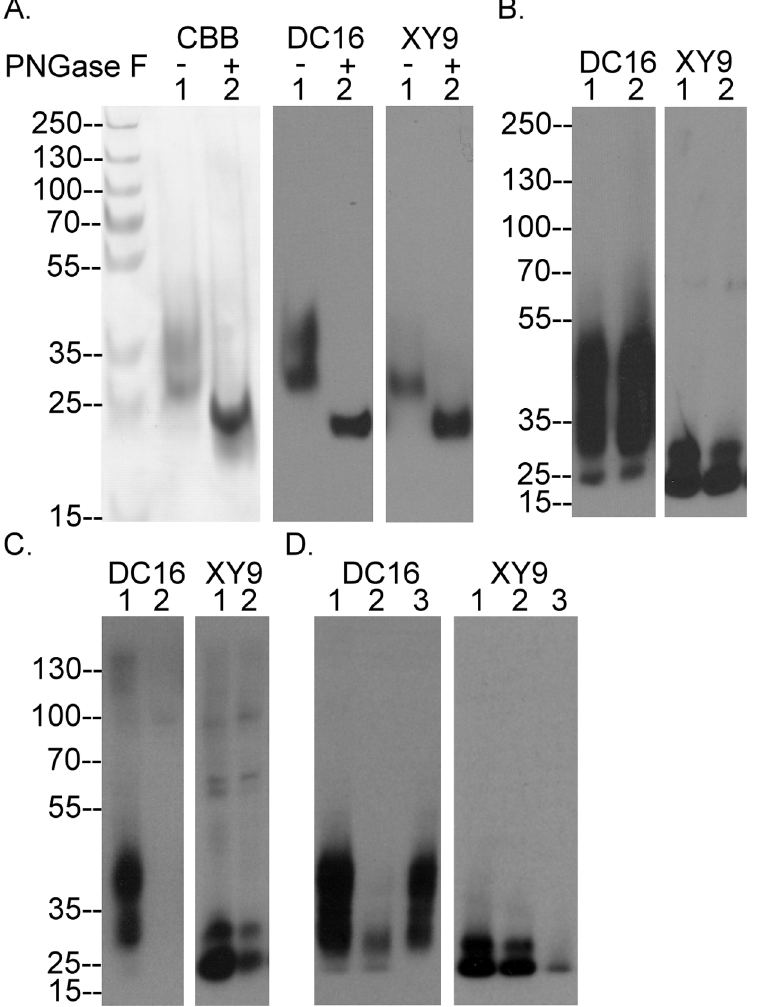
analyzed by SDS-PAGE and visualized by Coomassie Brilliant Blue (CBB) staining. The immunoreactivity of the HAI-2 preparations was analyzed by Western blot using the mAbs DC16 and XY9. The sizes of molecular markers were as indicated. (B) Naturally occurring HAI-2 from 184 A1N4 (lanes 1) and MTSV 1.7 (lanes 2) human mammary epithelial cells was analyzed by immunoblot using the mAbs DC16 and XY9. (C)